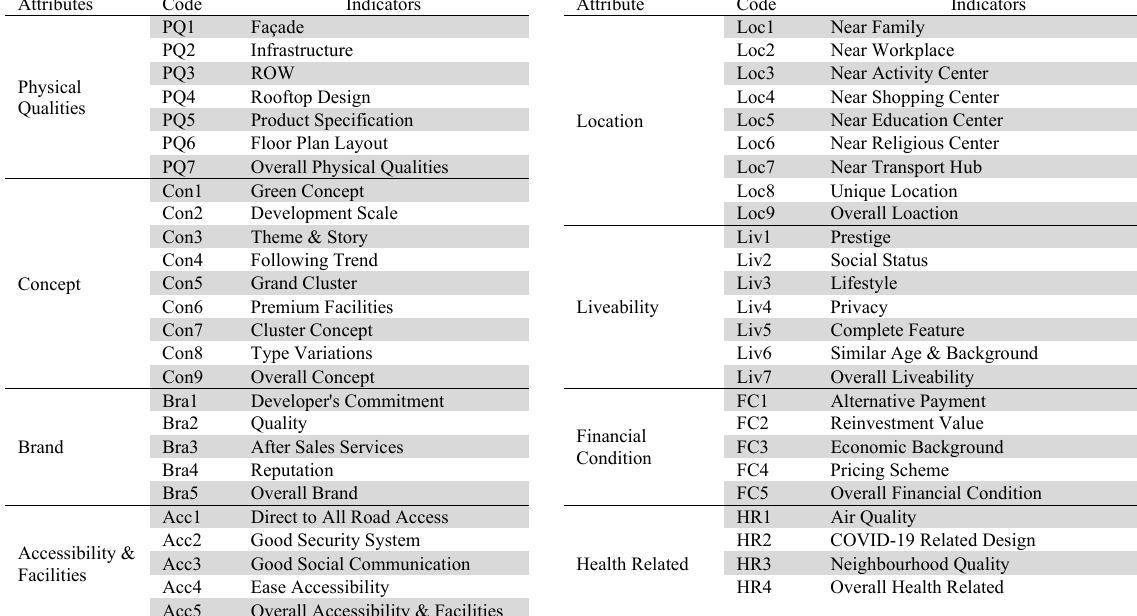
Attributes Influencing Housing Product